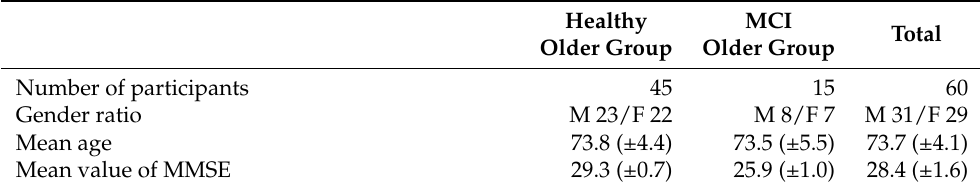
Table 2. Number of participants, gender ratio, mean age, and mean Mini-Mental State Exam (MMSE) score of